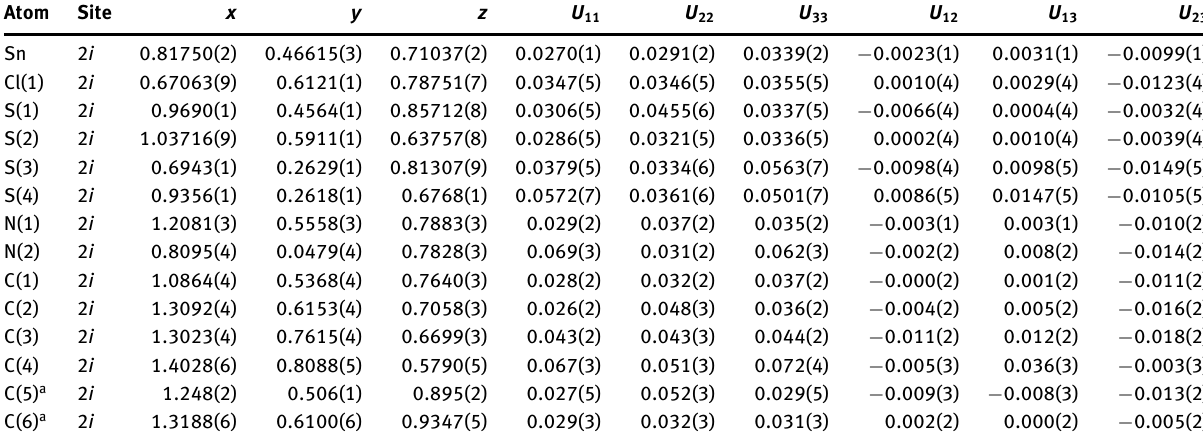
Table 3: Atomic displacement parameters (Å 2